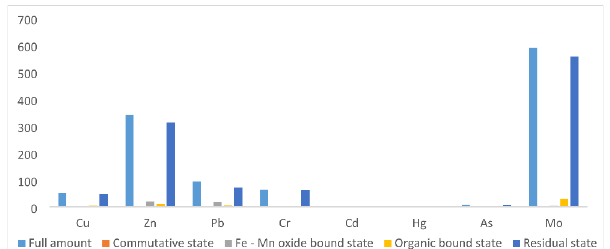
Fig. 4 Content of various forms of heavy metals in the soil of farmland around the tailing pond at the study site (mg/kg)